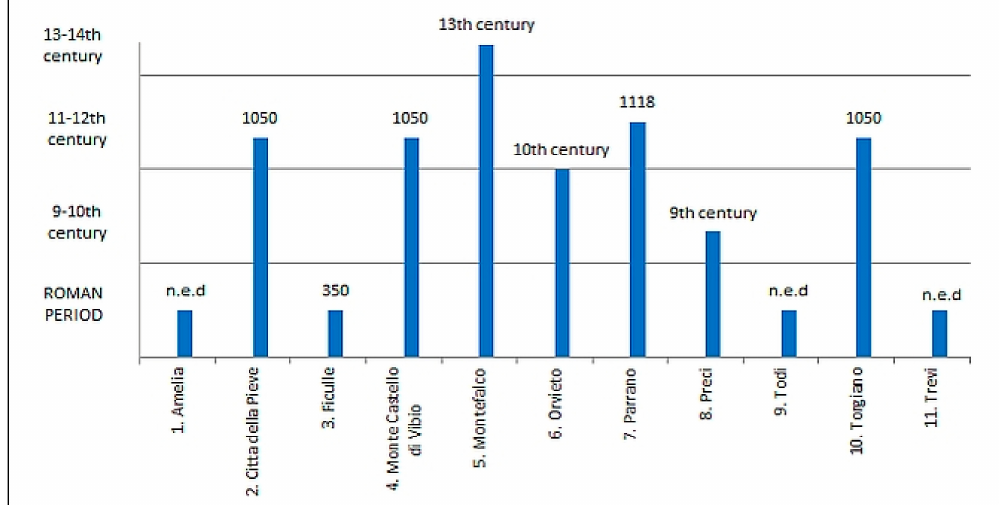
Figure 3. Founding dates of Umbrian towns. Source: own elaboration based on the data published by the Italian National Institute of Statistics [61] and Ross [63]. Key: n.e.d—no exact data